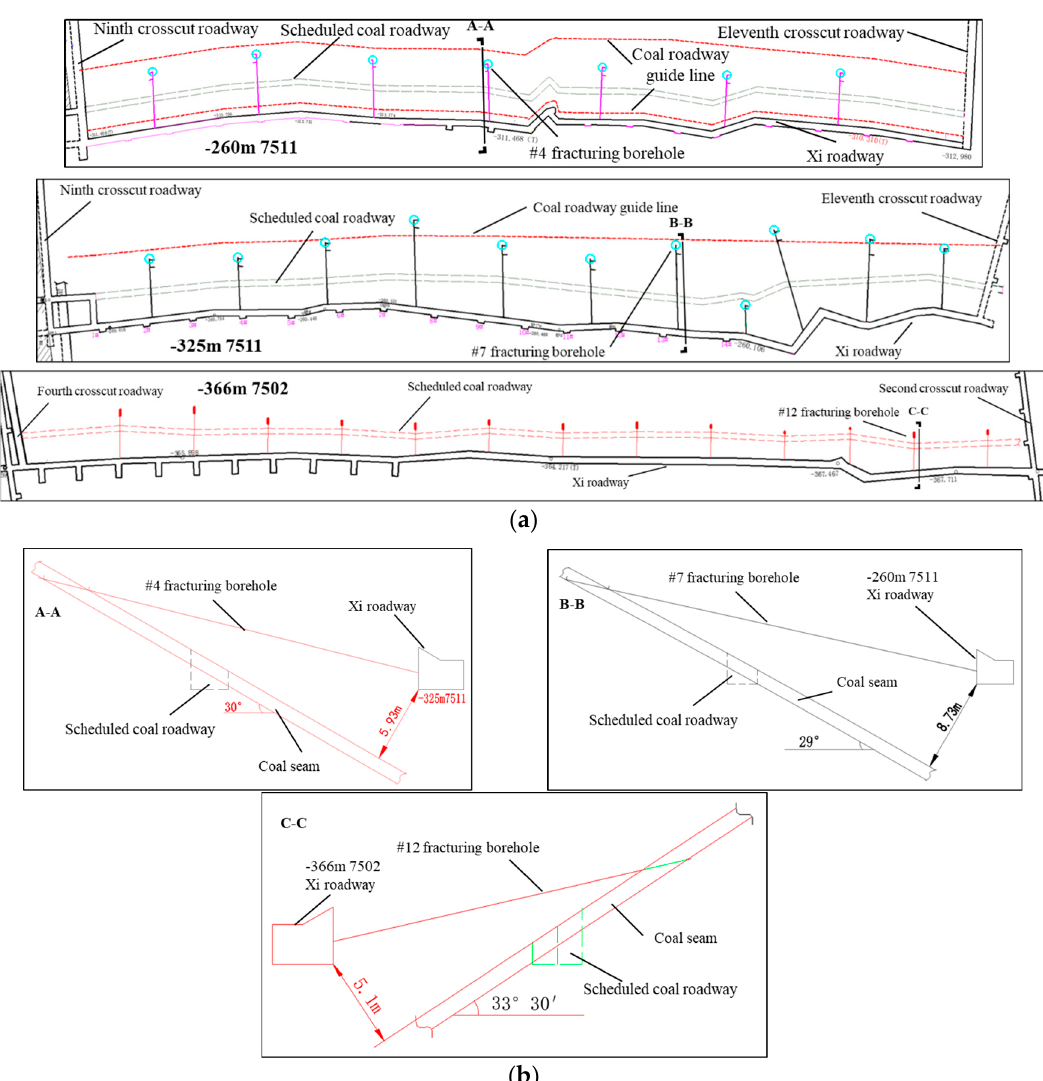
Figure 5. Design drawings of hydraulic fracturing in the three districts. ( a ) Plane figure; ( b ) Profile figure.